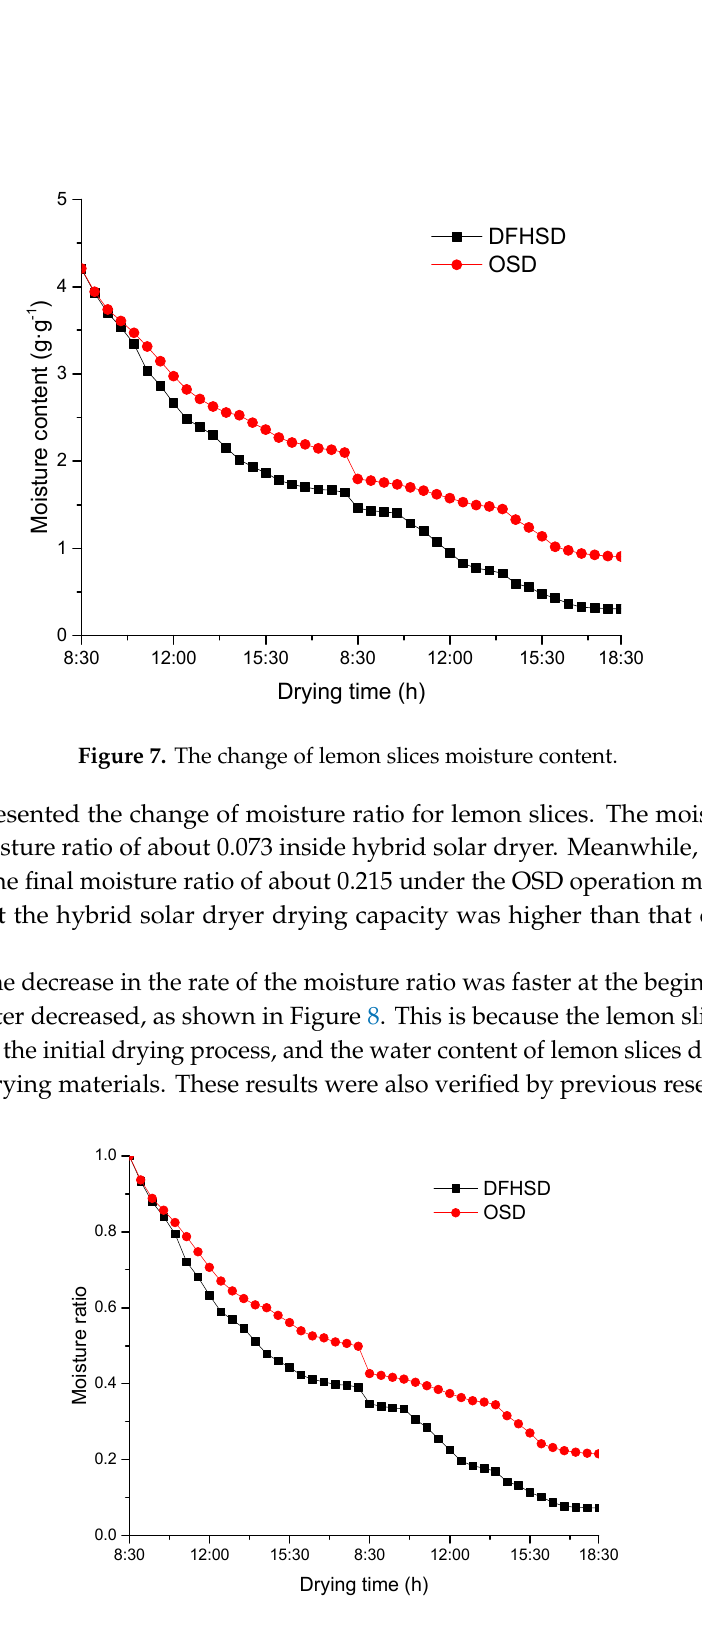
Figure 8. The change of moisture ratio for lemon slices’